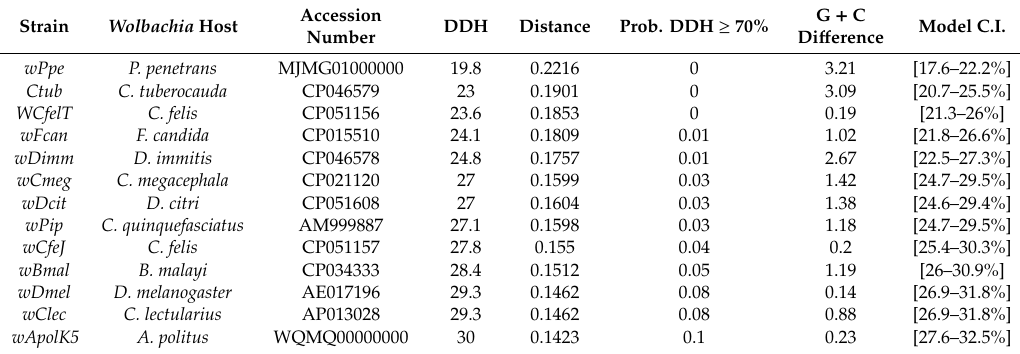
Table 2. dDDH values of the wChem PL13 comparatively to the other Wolbachia supergroups. Strain